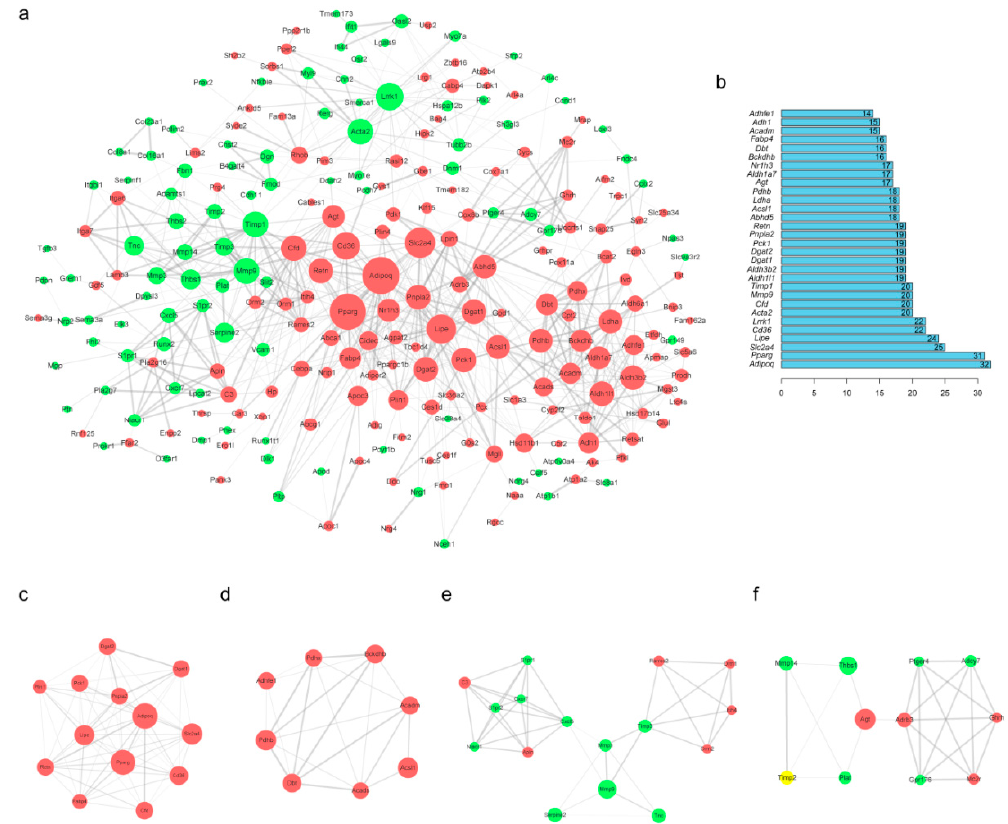
Figure 5. Protein–protein interaction (PPI) network construction and module analysis of DEGs associated with adipogenesis. ( a ) Using Cytoscape software, the PPI network was visualized (isolated nodes were removed). The node size represents the node degree (a larger size indicates a higher degree). The width and transparency of the edge indicate the combined score of the edge (a wider or more opaque edge indicates a higher combined score). ( b ) Top 30 genes with the highest degrees in the PPI network. ( c – f ) Molecular Complex Detection (MCODE) module screening for the DEGs, including module 1 (score = 11), module 2 (score = 6), module 3 (score = 5.467), and module 4 (score = 4.6).